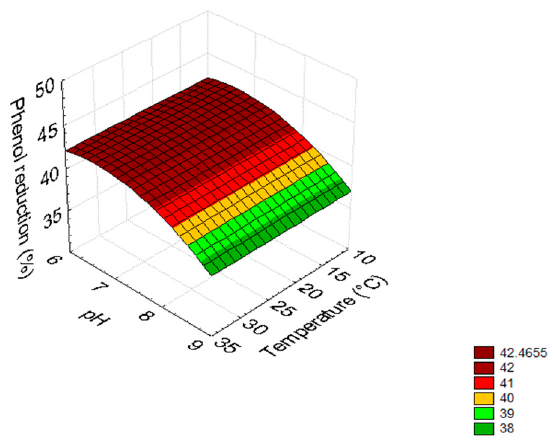
Figure 4. 3D plots for the interaction pH/temperature on phenol reduction (test 1: inoculum of C. boidinii followed 3 days after by B. pumilus ) in FTOPW (fresh table olive processing water) after 3 days. Test C of Table 3.